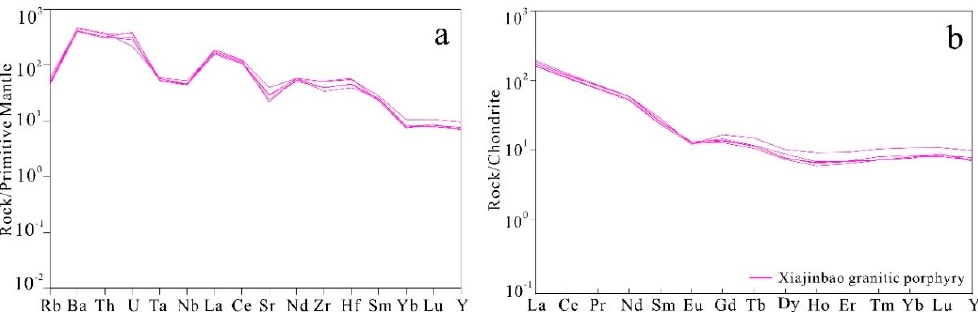
Figure 6. SiO 2 versus K 2 O ( a ) and A/NK versus A/CNK ( b ) diagrams for the Xiajinbao granitic porphyry.